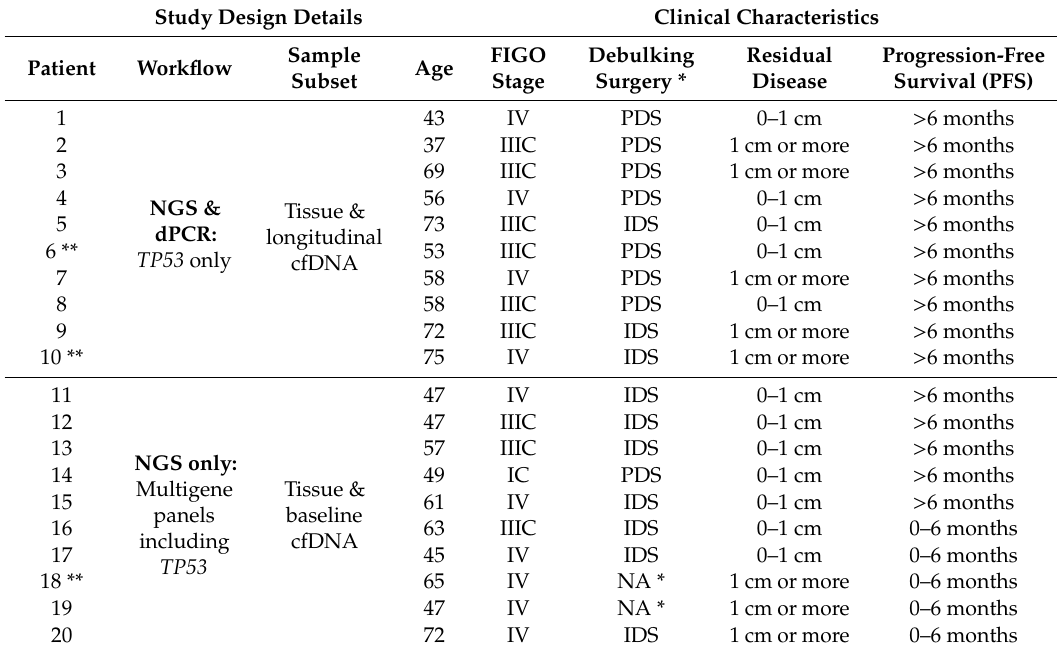
Table 1. Study design and clinical